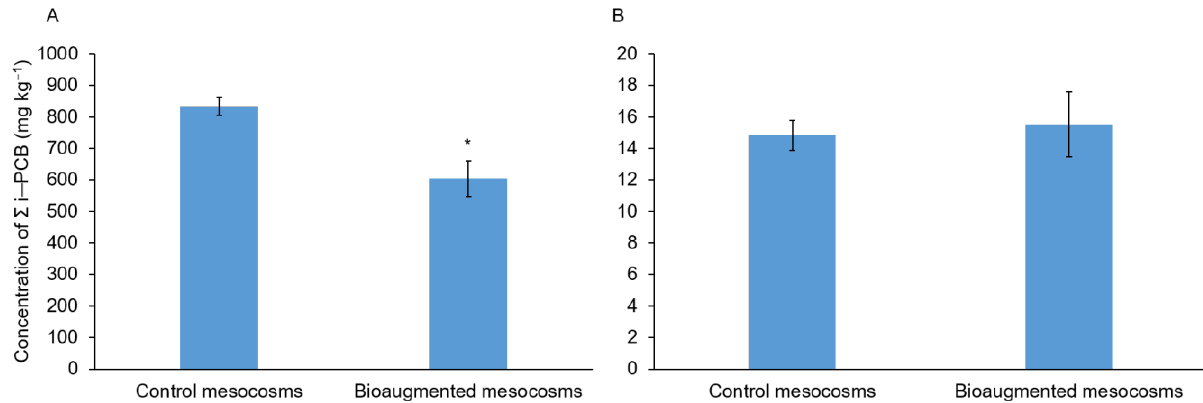
Figure 1. Concentrations of the seven PCBs in mesocosms after a three-month-treatment. ( A ) mesocosms with the soil H and ( B ) mesocosms with the soil L. Bars indicate mean ± standard deviation ( n = 3). Asterisk indicates significant differences between treatment (Student test; p -value < 0.05). Table 2. Comparison of PCB congener concentrations in bioaugmented and control mesocosms and percentage of degradation of each congener. Asterisk indicates significant differences between treatment (Welch test; p -value < 0.05).